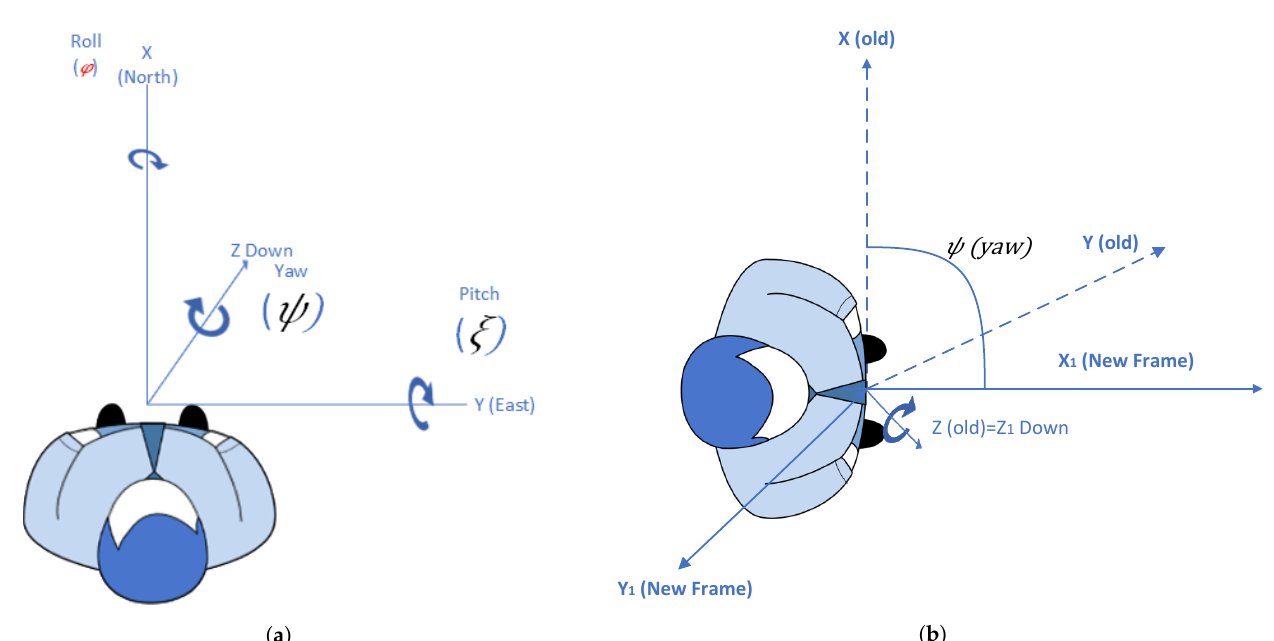
Figure 2. Quaternions calculation at north–east down (NED) reference. ( a ) Quaternions calculation at inertial frame; ( b ) Quaternions calculation at new